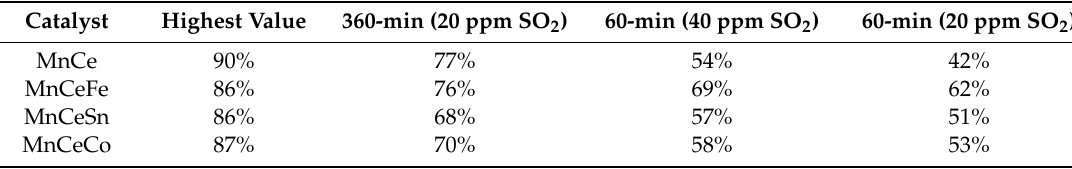
Table 7. NO conversion e ffi ciency values at four critical points.